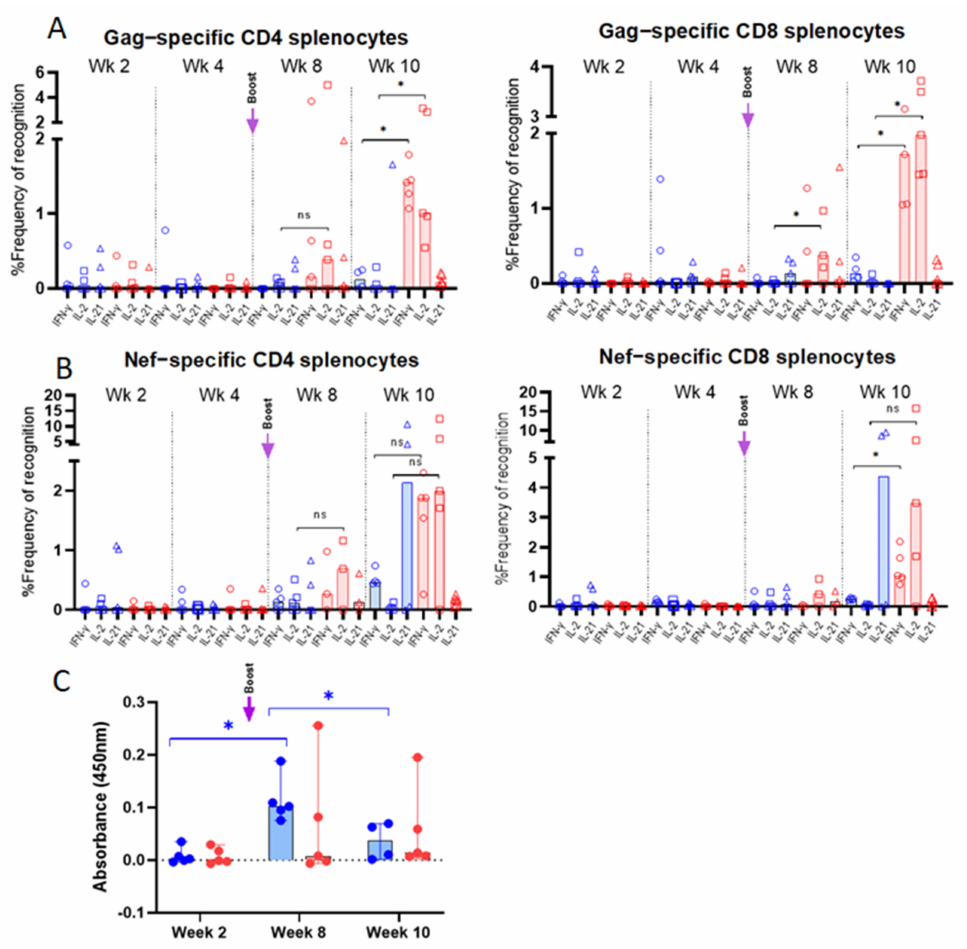
Figure 3. Flow cytometry characterization of vaccine-specific T cells in spleens of BALB/cJ-immunized mice: Splenocytes from group 1 (CAL-SHIV-IN − ; in blue) and group 2 mice (CAL-SHIV-IN − IRES-rmIL- 7 + CAL-SHIV-IN − IRES-rmIL-15; in red), harvested at different time points post-immunization, were stimulated with SIV-Gag and -Nef peptides. Cells were stained with the combination of Abs reported in Table 1, to identify Gag ( A ) and Nef ( B ) specific CD4 and CD8 cytokine-secreting T-cells. Results